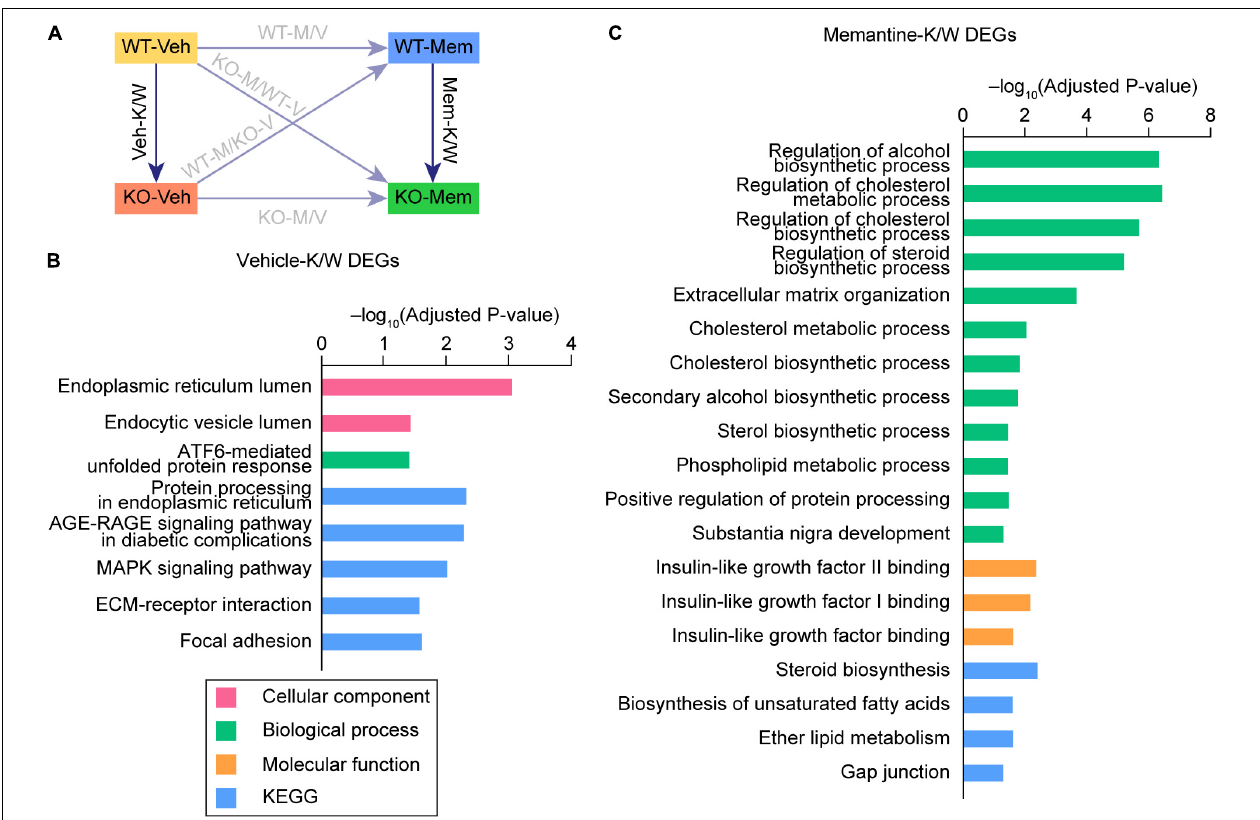
FIGURE 2 | Enrichr Gene Ontology (GO) analyses of DEGs for Veh-KO/WT and Mem-KO/WT transcripts. (A) Schematic depiction highlighting the differences between WT and KO mice under vehicle- and memantine-treatment conditions. (B,C) Enrichr GO analysis of DEGs (defined by adjusted p -values < 0.05) for Veh-KO/WT (Veh-K/W; B ) and memantine-KO/WT (Mem-K/W; C ) transcripts in cellular component (CC), biological process (BP), molecular function (MF), and KEGG domains (adjusted p -value < 0.05). DEGs for WT-M/V and KO-M/V were not subjected to Enrichr analysis because of their small